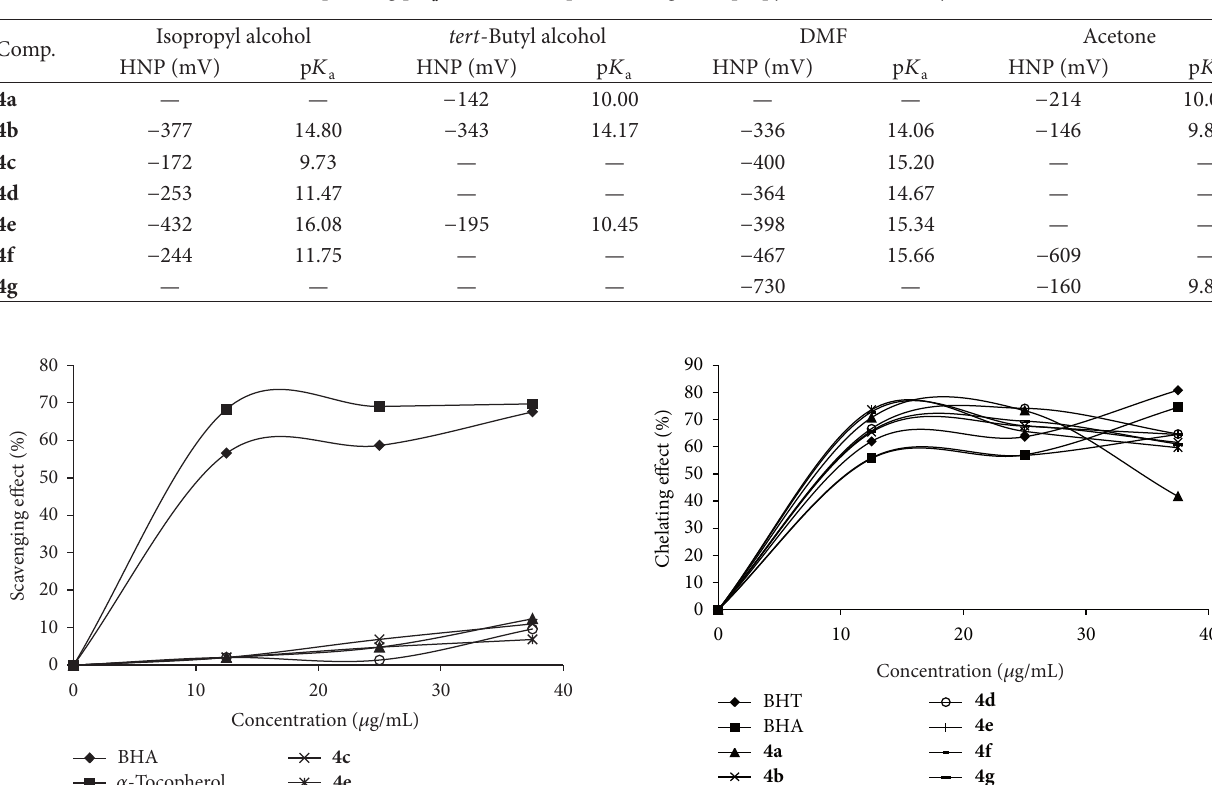
T 1: e HNP and the corresponding p